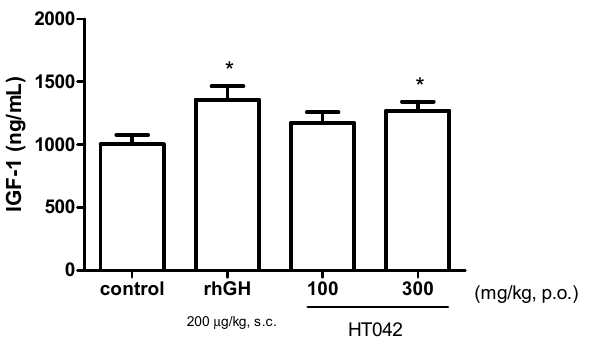
Figure 2. The serum level of insulin-like growth factor-1 estimated using enzyme-linked immunosorbent assay. Data are expressed as mean ± standard error ( n = 8 per group), * p < 0.05.